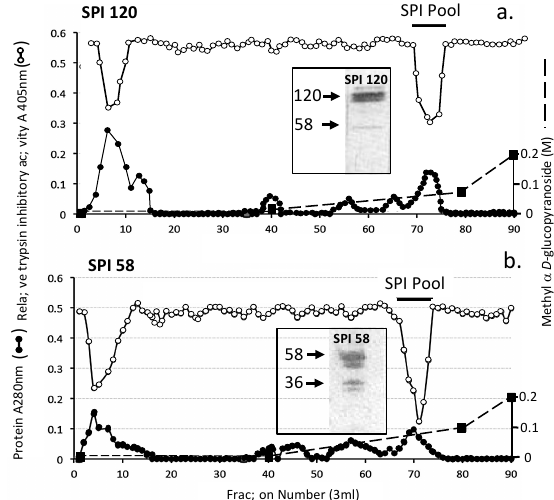
Figure 5. Concanavalin A affinity chromatography of SPI 120 ( a ) and SPI 58 ( b ) SPI pool 2 Figure 3a. The SPI58 pool was applied and the column eluted with 10 bed volumes of starting buffer (50 mM Tris, 200 mM NaCl buffer pH 7.2 starting buffer containing 1 mM CaCl 2 , 1 mM MgCl 2 , and 1 mM MnCl 2 ). Bound material was eluted with a linear 0–0.2 M gradient of methyl α-glucopyranoside as shown. The inset shows active 58 and 36 kDa SPIs on bT affinity blots of the SPI58 sample prior to and after Concanavalin A affinity chromatography.